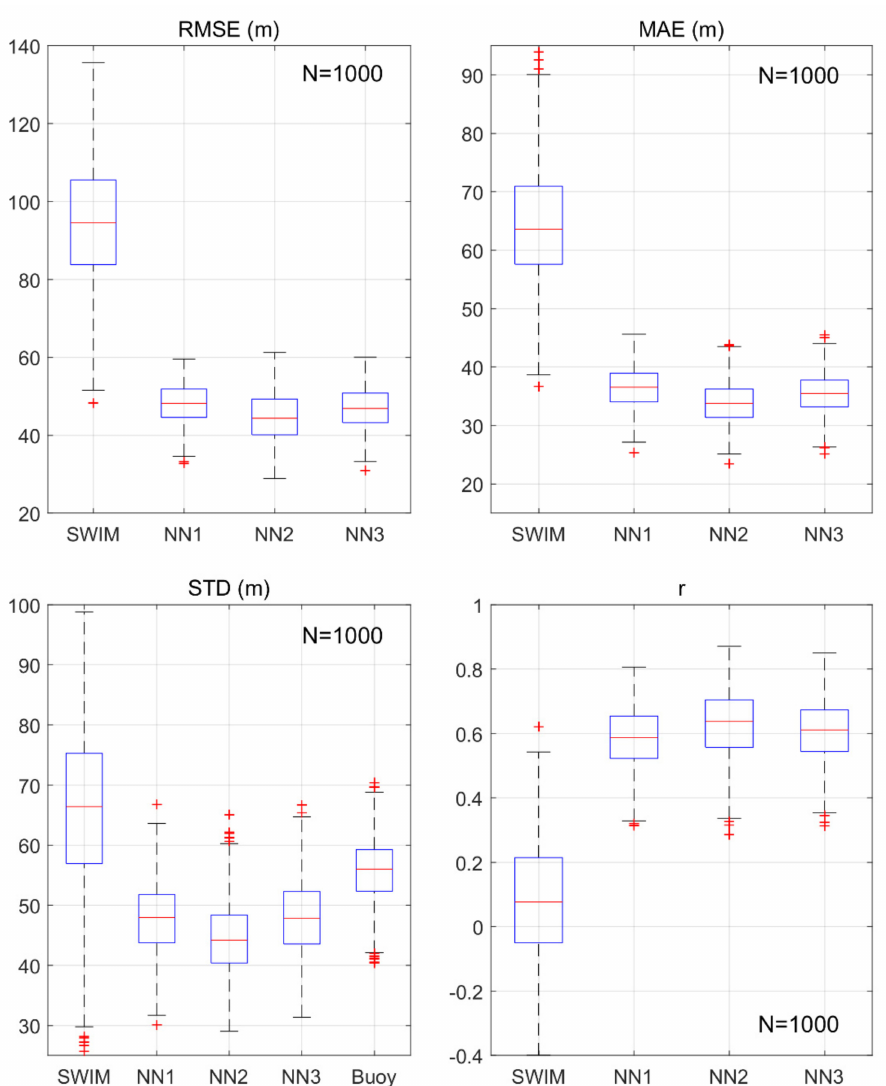
Figure 7. Boxplots of the RMSE, MAE, STD, and r of the SWIM observed dominant wavelengths and the validation results in the three-stage NN models (NN1, NN2, and NN3) based on self- calibration in which only CFOSAT parameters (Table 1) were used. Points in red “+” are drawn as outliers if they are larger than the maximum (Q3 + 1.5 × (Q3 − Q1)) or smaller than the minimum (Q1 − 1.5 × (Q3 − Q1)), where Q1 and Q3 are the 25th and 75th percentiles,